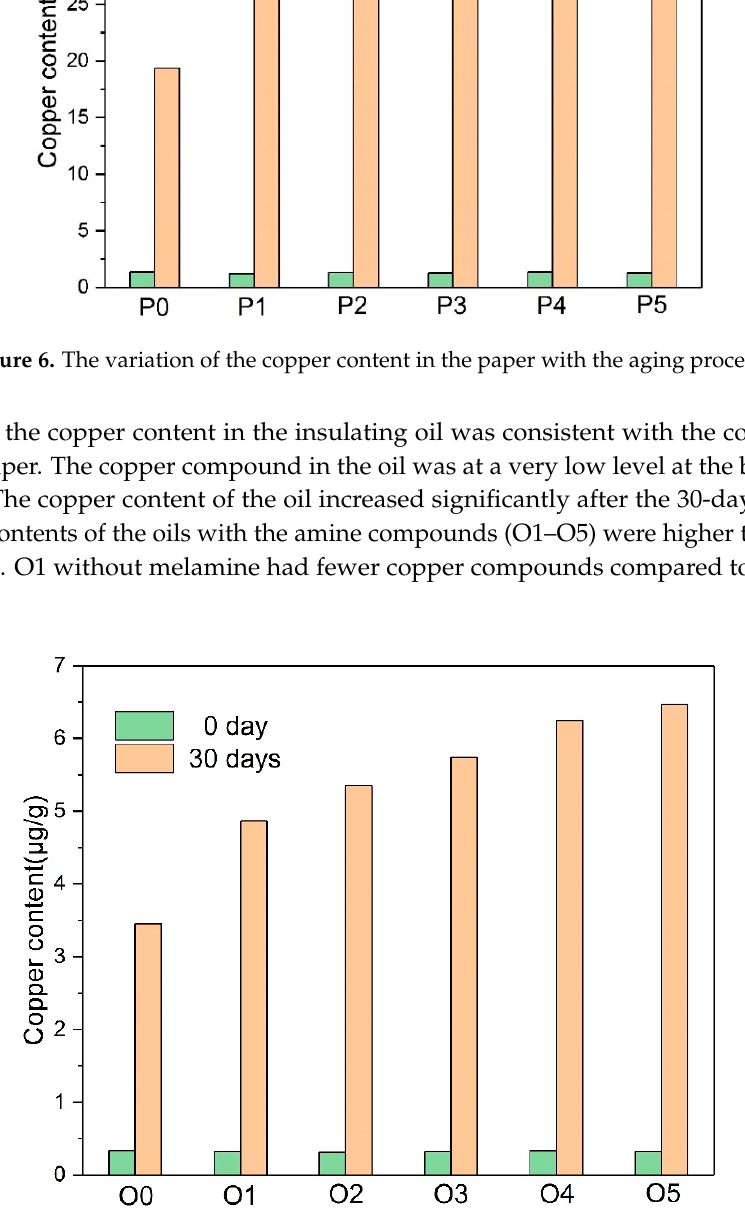
Figure 7. The variation of the copper content in the oil with the aging process.